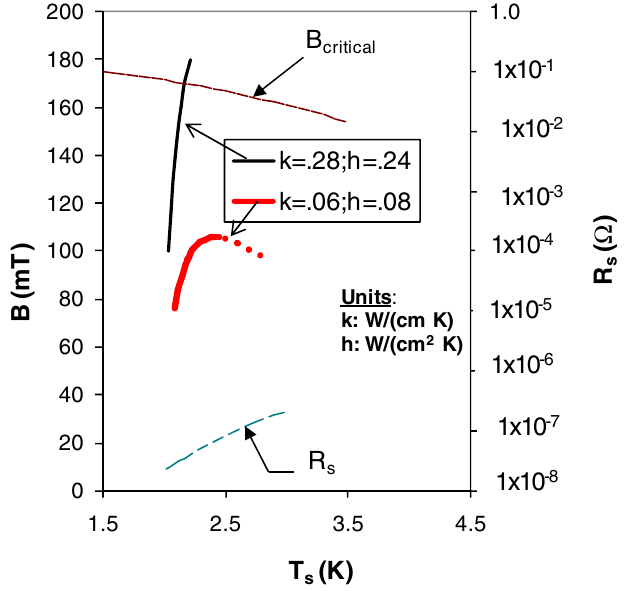
FIG. 2. (Color) Thermal-magnetic numerical estimates with constant thermal properties, k and h , for the two cases are shown. About 5 times increase in k and 3 times increase in h resulted in almost 50% improvement in applied magnetic fields. Parameters used for these numerical estimates are R res ¼ 5 n(cid:2) , e ¼ 3 mm , ¼ 2 K , f ¼ 1 : 3 GH z , and RRR ¼ 230 . The rise in surface T b resistance (right axis) due to rf surface temperature increase is also